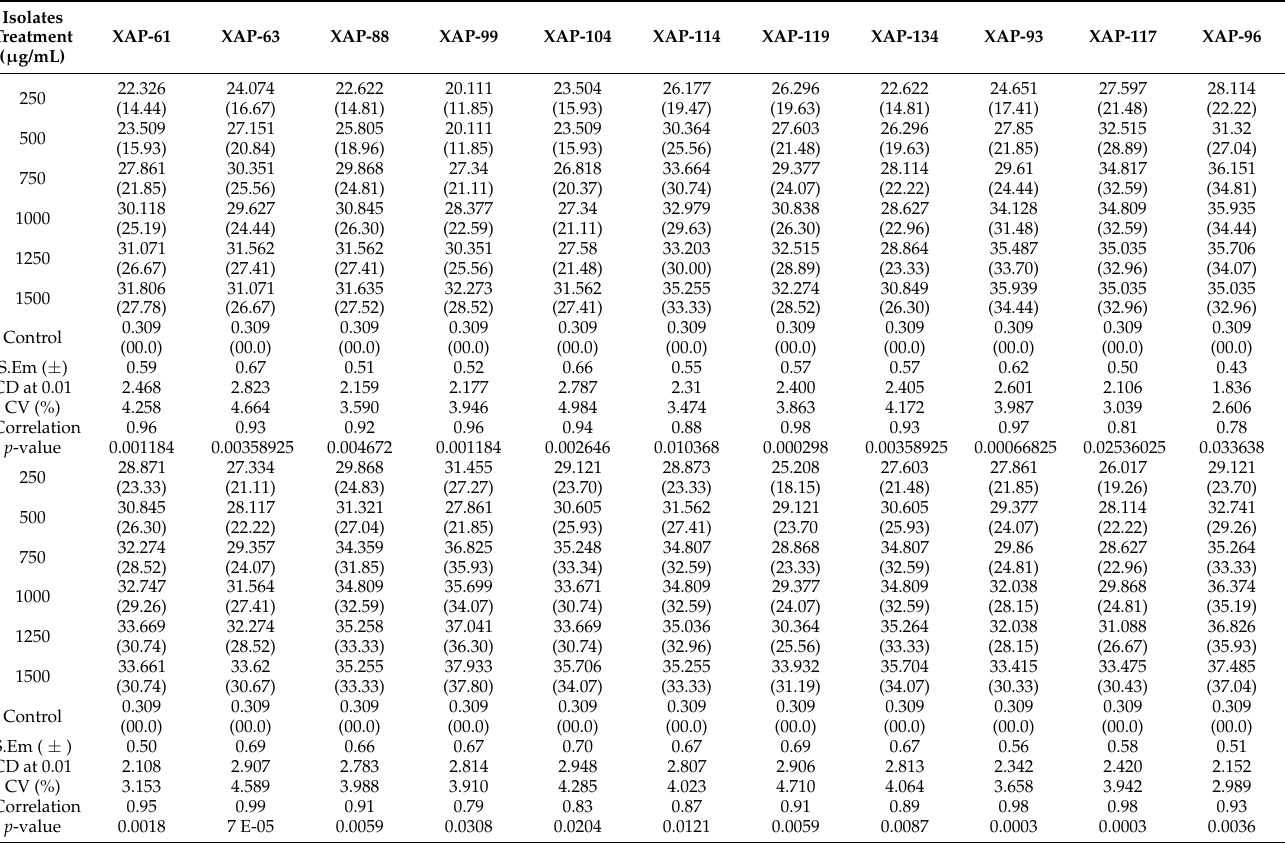
Table 5. In vitro sensitivity of Xap isolates to different concentrations of streptomycin.